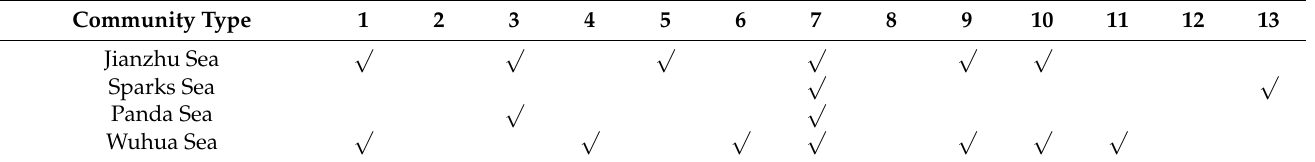
Table 4. Lake plant communities and their distribution in